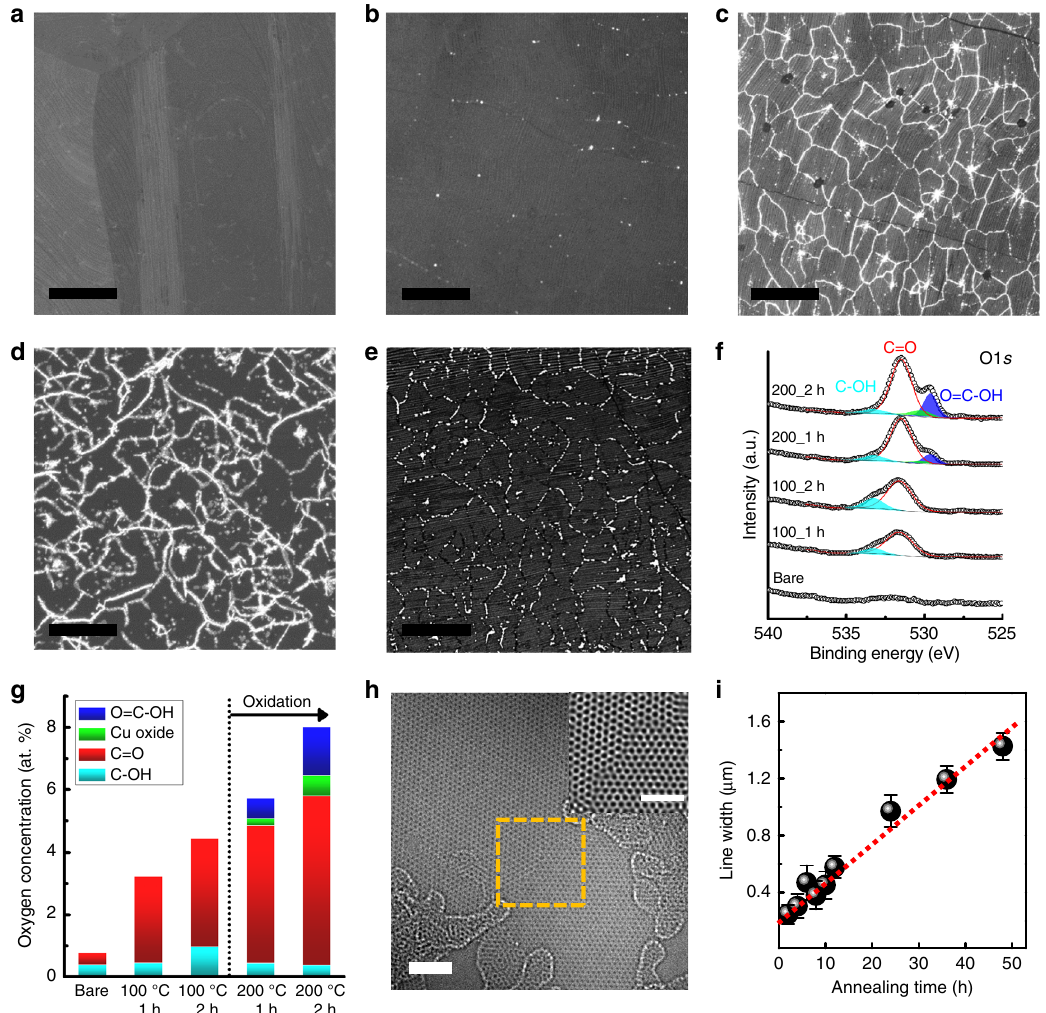
Fig. 4 Control experiments to elucidate the origin and process of Cu oxidation through a polycrystalline graphene barrier. Typical SEM images of fully- grown Gr/Cu samples annealed at ~200 °C a for 120 min under vacuum (P ≈ 10 − 3 Torr), b for 120 min in a pure O 2 atmosphere (P ≈ 150 Torr), c for 120 min in ambient air (RH ≈ 30 – 40%), d for 60 min in a wet-O 2 atmosphere (RH ≈ 80%), and e for 60 min in a wet-N 2 atmosphere (RH ≈ 50%). The scale bars represent 10 µ m. f , g A comparison of the HR-XPS O 1s peaks and of the chemical compositions of the Gr/Cu samples depending on the annealing temperature and time in ambient air. h Representative plan-view HR-TEM image of a Gr fi lm transferred onto a TEM support grid (scale bar: 2 nm). The inset is an atomic-resolution image of a GB of Gr, indicated by a yellow square (scale bar = 0.5 nm). i Plot of the average width of the oxidation line feature as a function of annealing time up to 48 h based on the SEM observation. Error bars represent ± 1 standard deviation, obtained from 100 different points in each